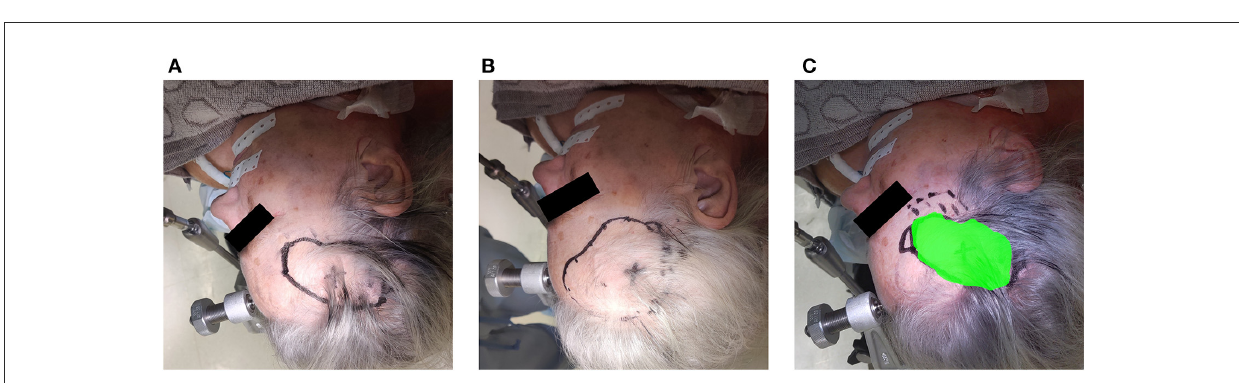
FIGURE11 Example of the assessment of delineation accuracy: (A) delineation using the AR system; (B) delineation using the conventional neuronavigation system; (C) control based on expert